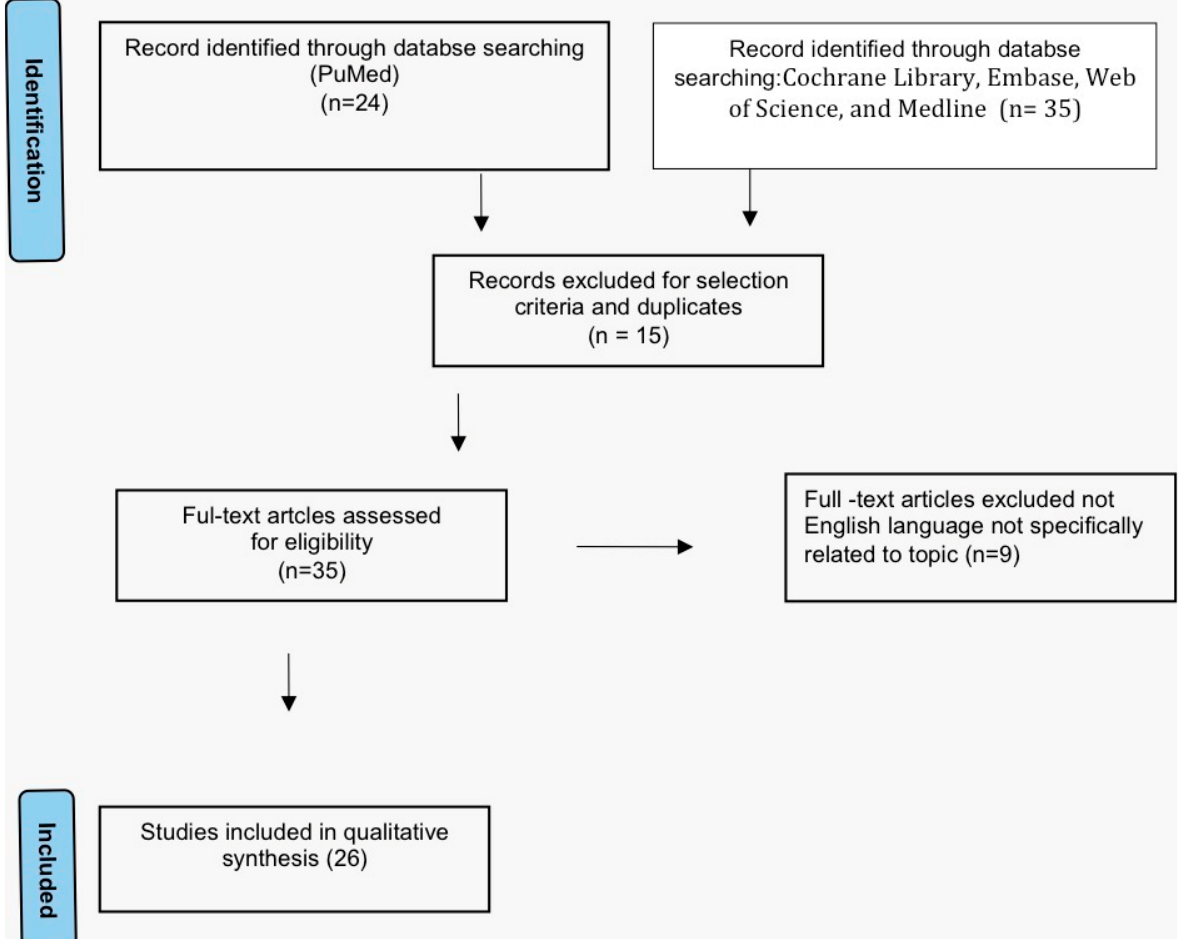
Figure 1. Study flow diagram: PRISMA flow diagram of identification, screening and inclusion of articles. Systematic literature reviews were selected with standard methods to be briefly presented in the article.